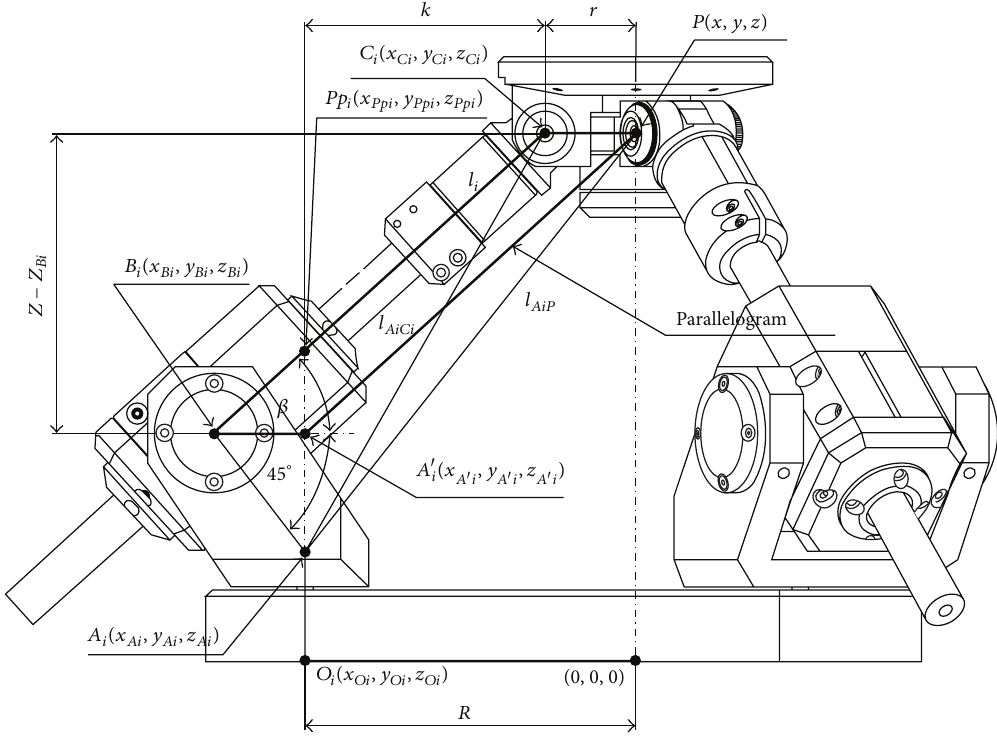
Figure 3: Geometry characteristic of the microrobot’s 𝑖 th